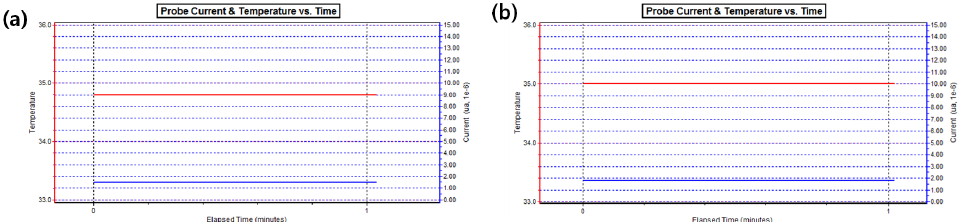
Figure 5. Probe current and temperature versus time in optic zone of ( a ) Ref sample and ( b ) M0.1N5S1 sample.